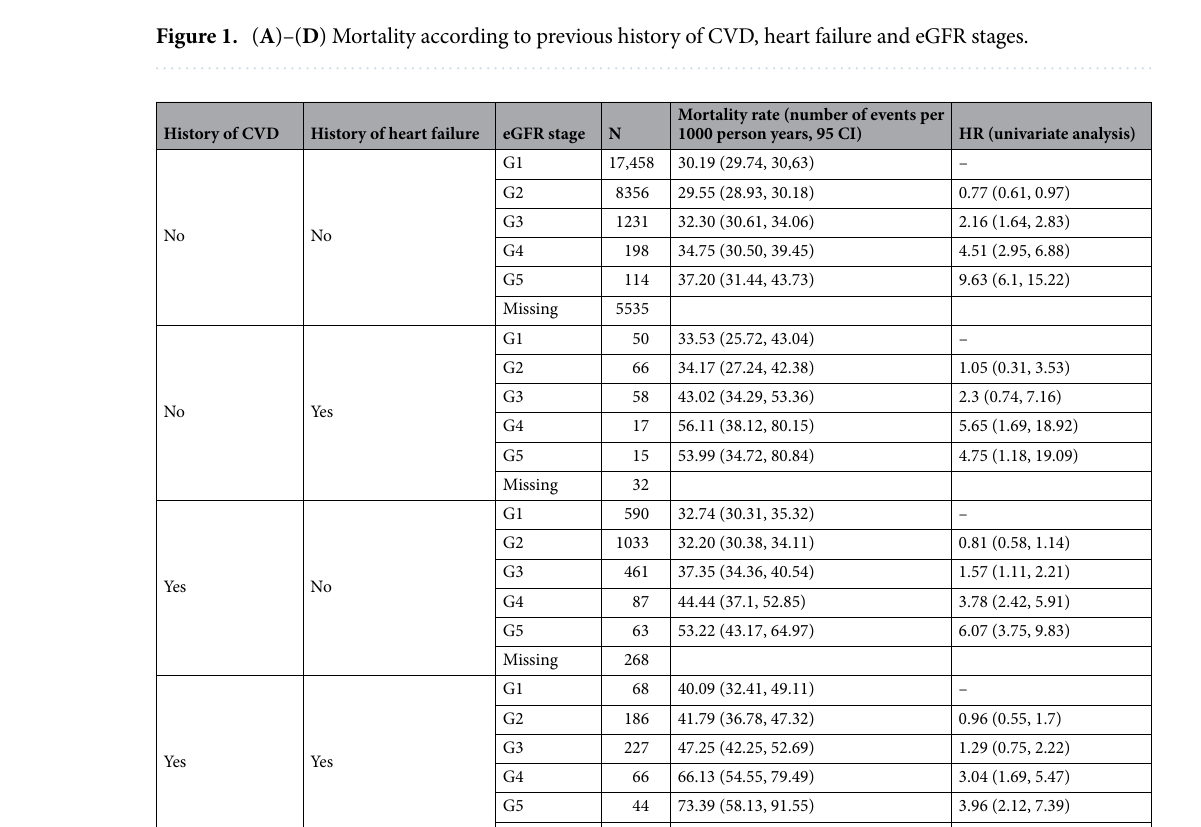
Table 3. Mortality rates and risk according to risk group, adjusted for age at baseline (Cox regression).